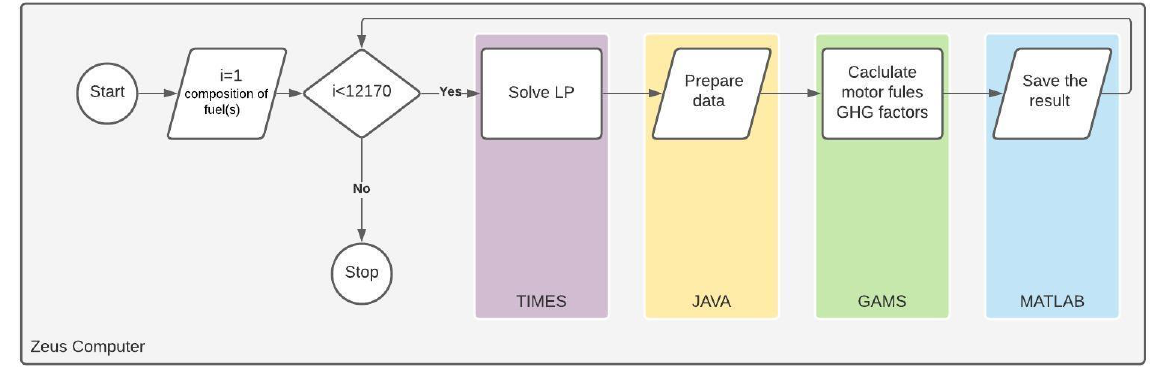
Figure 2. Algorithm for conducting GHG emission simulations for determining the optimum fuel component composition.